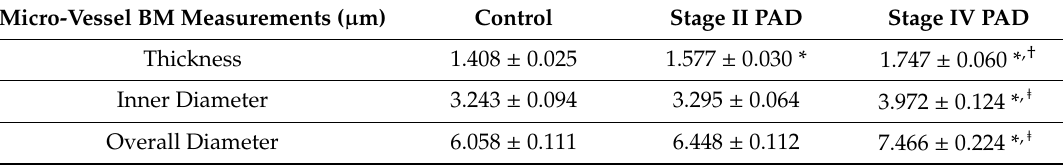
Table 1. Patient demographics.